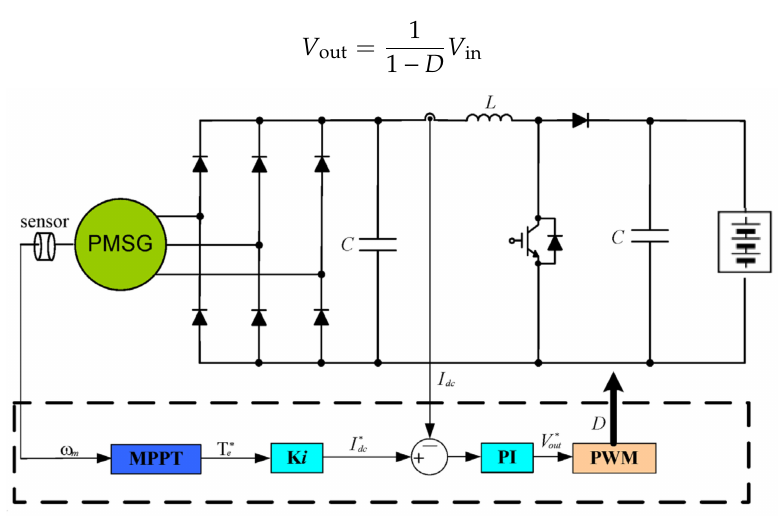
Figure 4. Block diagram of DC / DC boost converter.